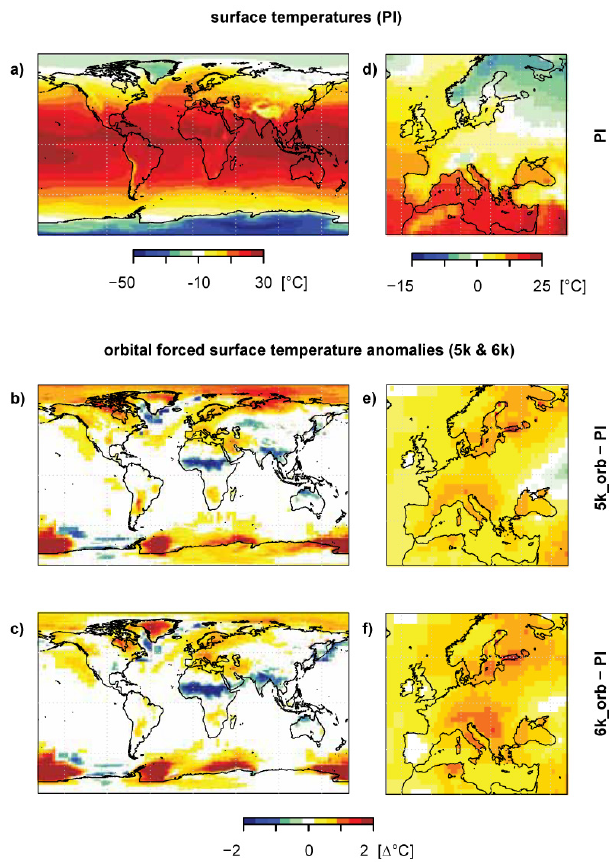
Fig. 2. Upper row: simulated surface temperature for the pre- industrial climate simulation (PI). Middle and lower row: simulated temperature anomalies for both orbital-driven experiments of the mid-Holocene (5k orb, 6k orb) as compared to the PI simulation. Anomaly values with less than 0.5 of the standard deviation are shaded in white. The right column shows the results for Europe,